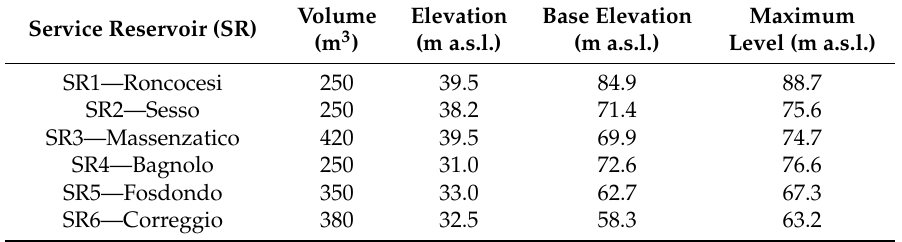
Table 2. Main features of the service reservoirs (SRs) belonging to the Roncocesi and Luzzara networks. Service Reservoir